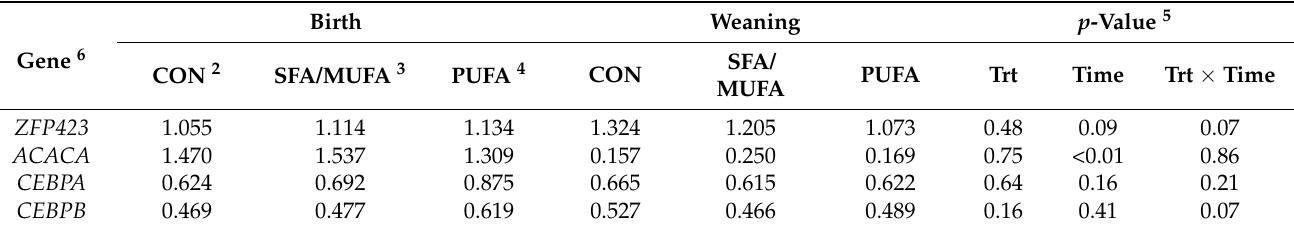
Table 12. Relative mRNA expression of genes regulating adipogenesis in subcutaneous adipose tissue of the steers (4 steers per group) born from dams supplemented soybean hulls mixed with either whole-shelled corn (CRN), Ca salts of saturated/monounsaturated fatty acids (SFA/MUFA), or Ca salts of polyunsaturated fatty acids (PUFA2) for the last 82 ± 5 d of gestation 1